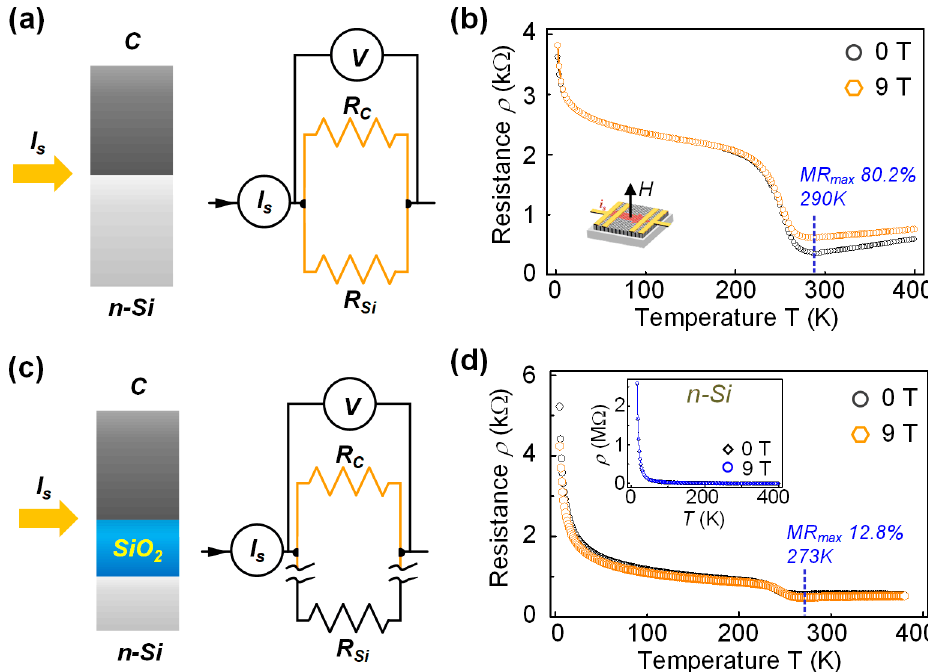
Figure 4. ( a ) Schematic illustration and equivalent circuit of the C-film/n-Si device. I s is the source current, and R c and R si represent the resistance of the carbon film and n-Si substrate, respectively. ( b ) R–T relationship of the C-film/n-Si device in 0 T and 9 T conditions. ( c ) Schematic illustration and equivalent circuit of the C-film/SiO 2 device. ( d ) R–T relationship of the C-film/SiO 2 device in 0 T and 9 T conditions. Inset figure is the R–T relationship of n-Si substrate.